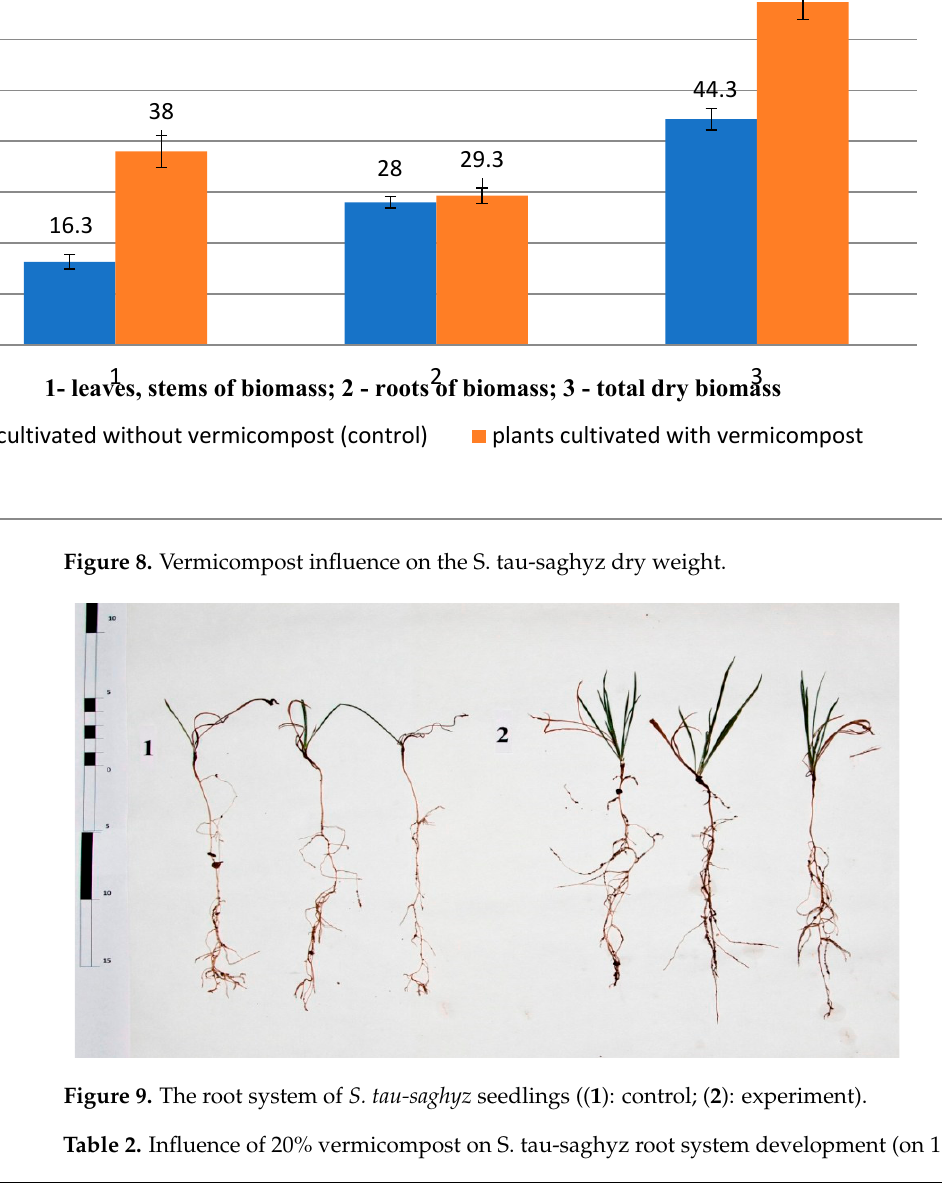
Figure 8. Vermicompost influence on the S. tau-saghyz dry weight.